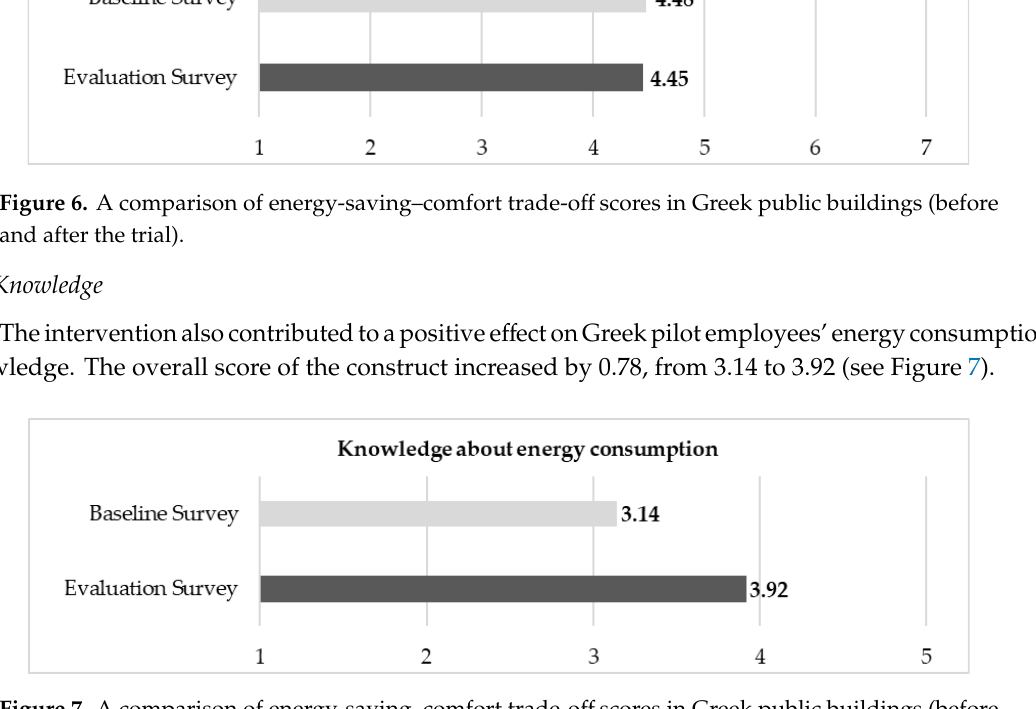
Figure 7. A comparison of energy-saving–comfort trade-off scores in Greek public buildings (before and after the trial).